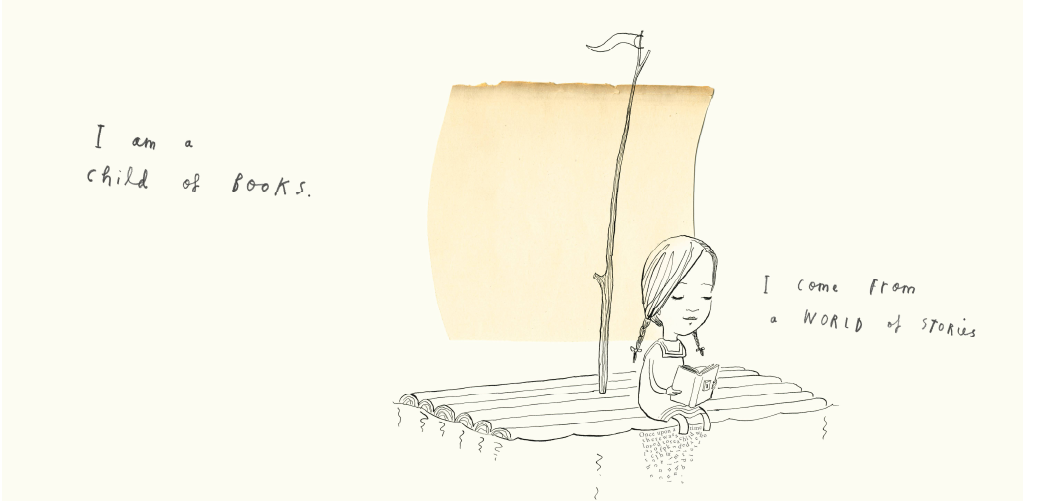
Figure A12. Jeffers, O.; Winston, S. A child of books, Walker Books, London, 2016.